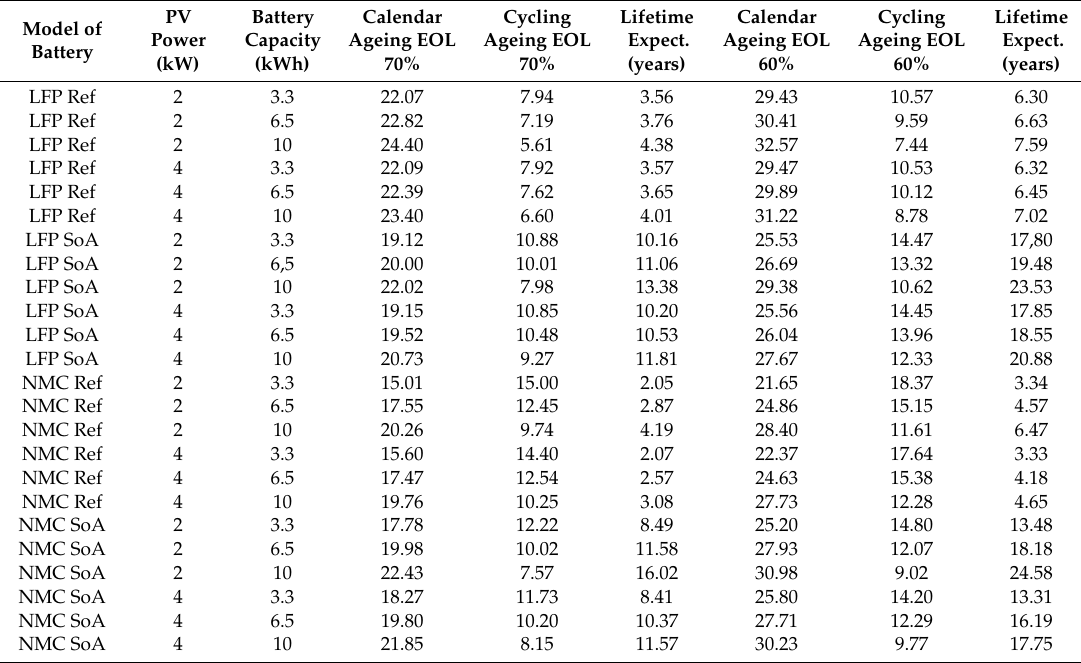
Table 3. Lifetime expectancy results for the di ff erent batteries at household 1 in location A. Model of